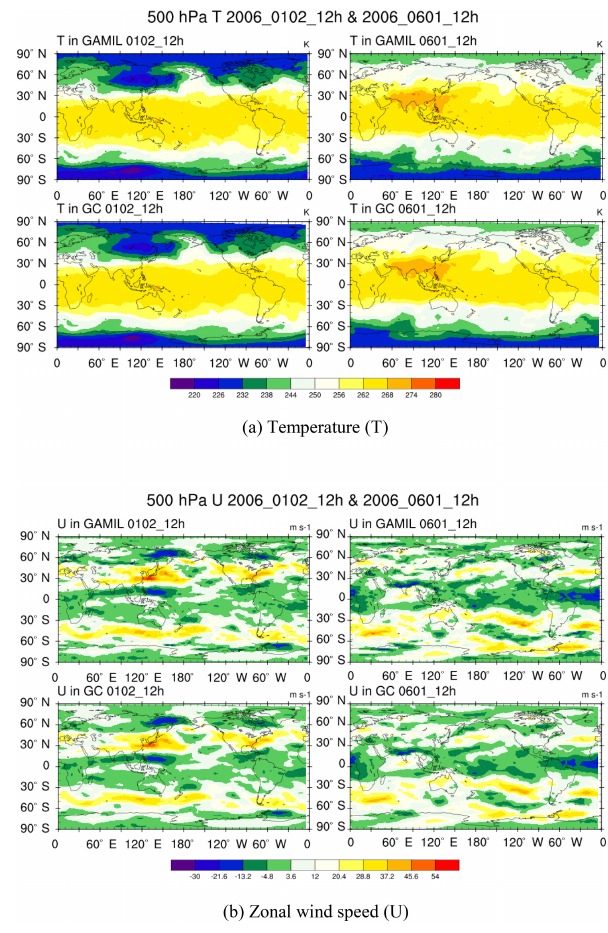
Figure 11. The temperature, T (a) , and zonal wind speed, U (b) , from GAMIL2 to GEOS-Chem (GC) at the 500hPa level at two different model